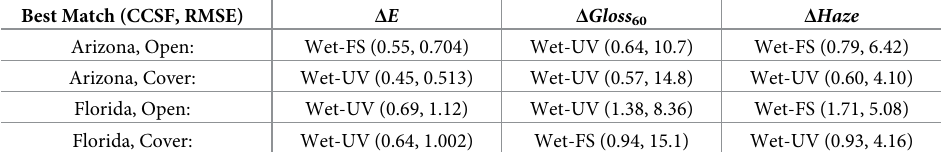
Table 11. Cross-correlation scale factors and RMSE values for the best match indoor sub-model for each outdoor sub-model for clear